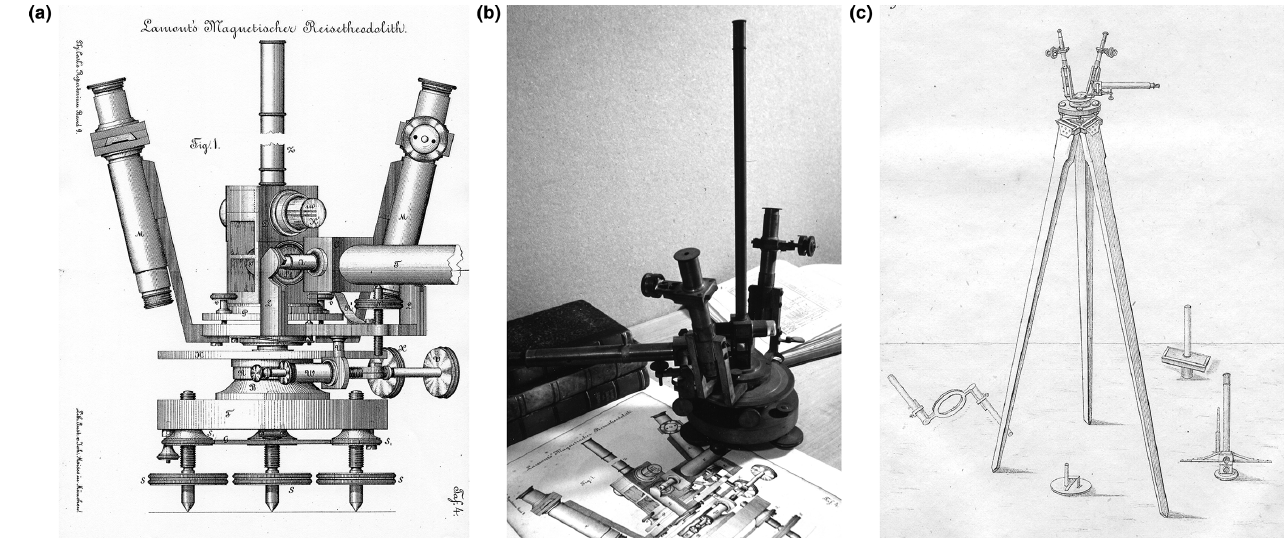
Figure 5. Lamont’s nonmagnetic theodolite ( Reisetheodolit ). (a) Construction drawing of the instrument. (b) Photograph of the instrument in our observatory. (c) Theodolite mounted on a tripod and additional equipment for measurements of D , H and I in the